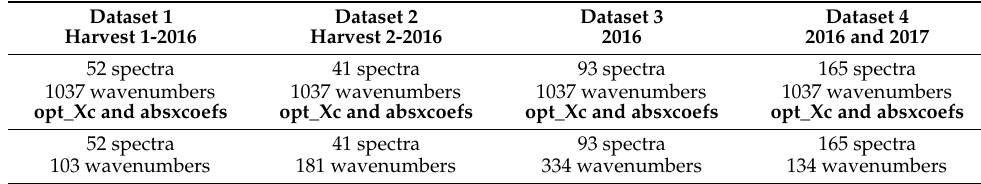
Table 1. Formulation of the